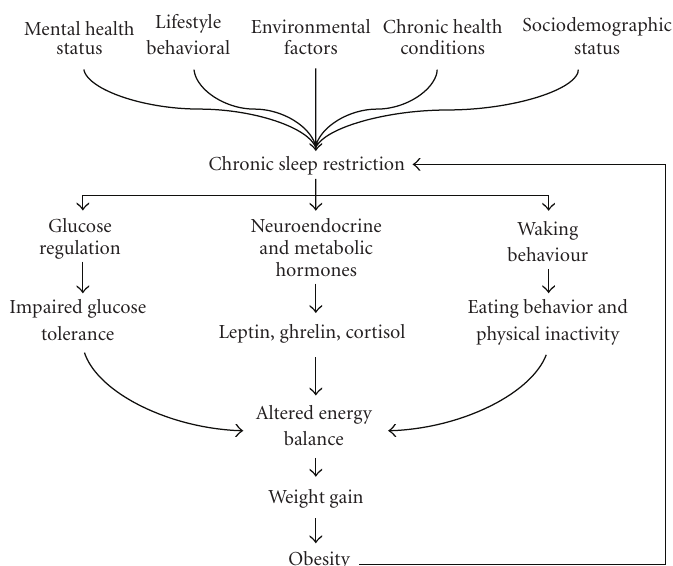
Figure 1: Schematic representation of the pathways linking chronic sleep restriction to